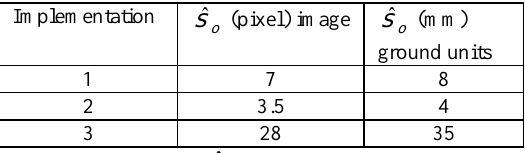
Table 1: A posteriori for the three implementations